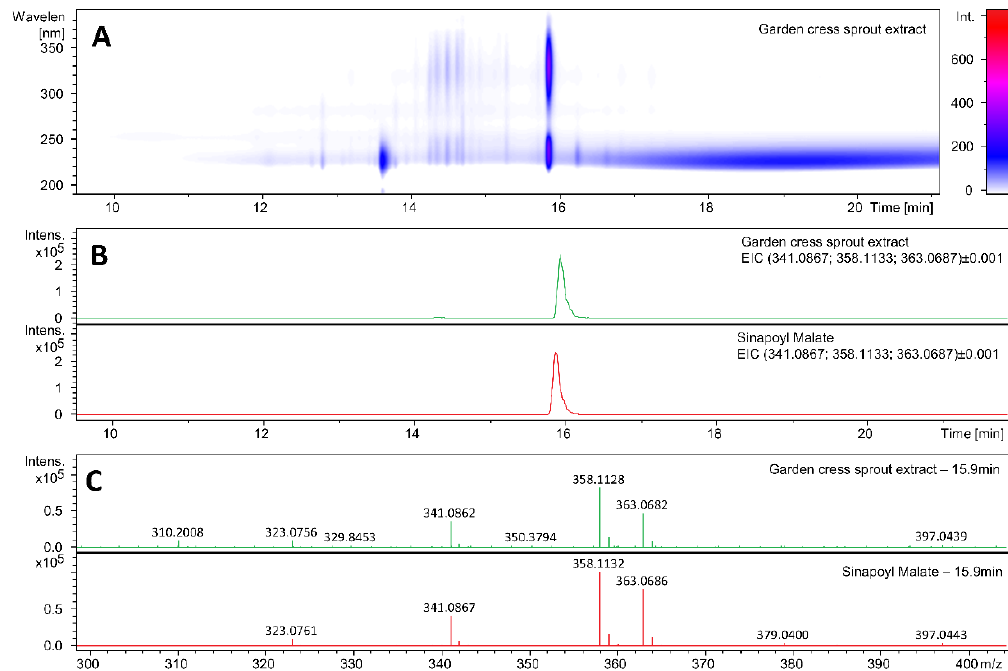
Figure 2. ( A ) UHPLC analysis of the garden cress sprout extract, highlighting compounds eluting at between 10 and 20 min and absorbing in the 210–390 nm range. ( B ) Extracted ion chromatogram of cress sprout (green) and sinapoyl malate standard (red) for m/z values calculated for [SM+H] + , SM ammonium adduct, and SM sodium adduct ( C ) Mass spectra for cress sprout and sinapoyl malate at retention time of 15.9 min.